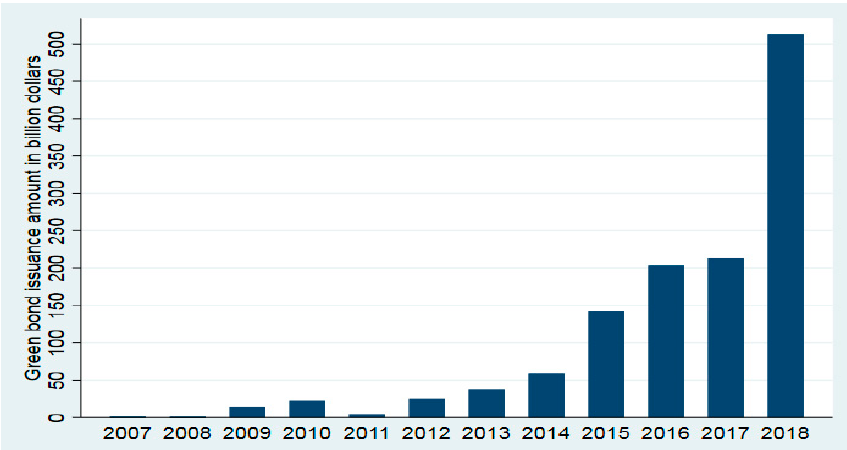
Figure 1. Corporate green bonds over time. This figure plots the total issuance amount (in $B) of corporate green bonds on an annual basis, using our sample of corporate green bonds during 2007–